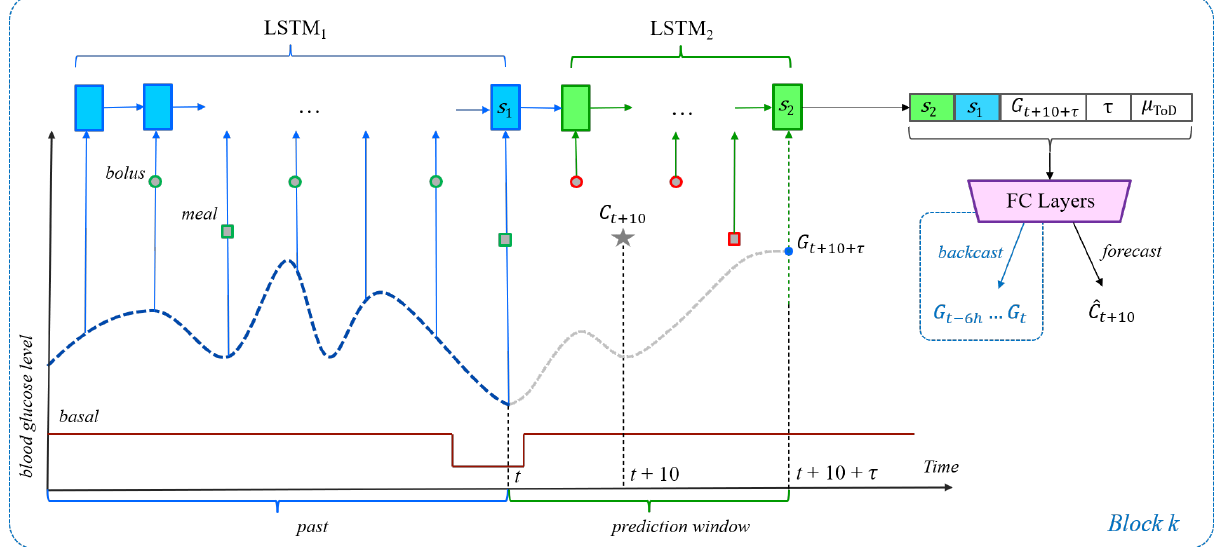
Figure 1. The neural network architecture for the carbohydrate recommendation scenario. The dashed blue line plots BG levels, while the solid red line represents the basal rate of insulin. The gray star represents the meal event at time t + 10. Other meals are represented by squares, whereas boluses are represented by circles. Meals and boluses with a red outline can appear only in unrestricted examples. The blue LSTM 1 units receive input from time steps in the past. The green LSTM 2 units receive input from time steps in the prediction window. The purple block stands for the fully connected layers of the FCN that computes the